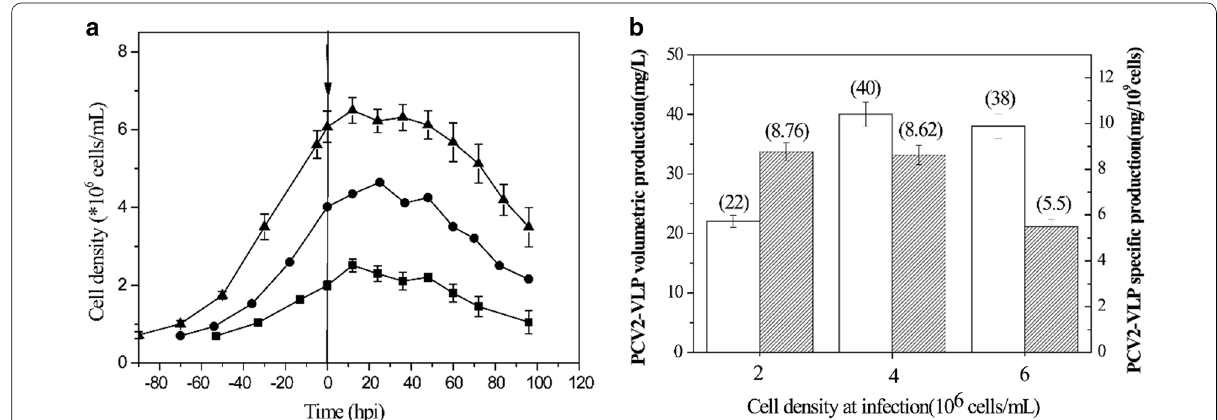
Fig. 4 Production of PCV2-VLP in 1.5 L bioreactor batch cultures. The CDI ranged from 2 to 6.0 the vertical arrow. Data represents the average of three bioreactor runs. Error bars represent standard deviation. a Cell growth profile. b PCV2-VLP volumetric production (white bars) and specific production (shaded bars)